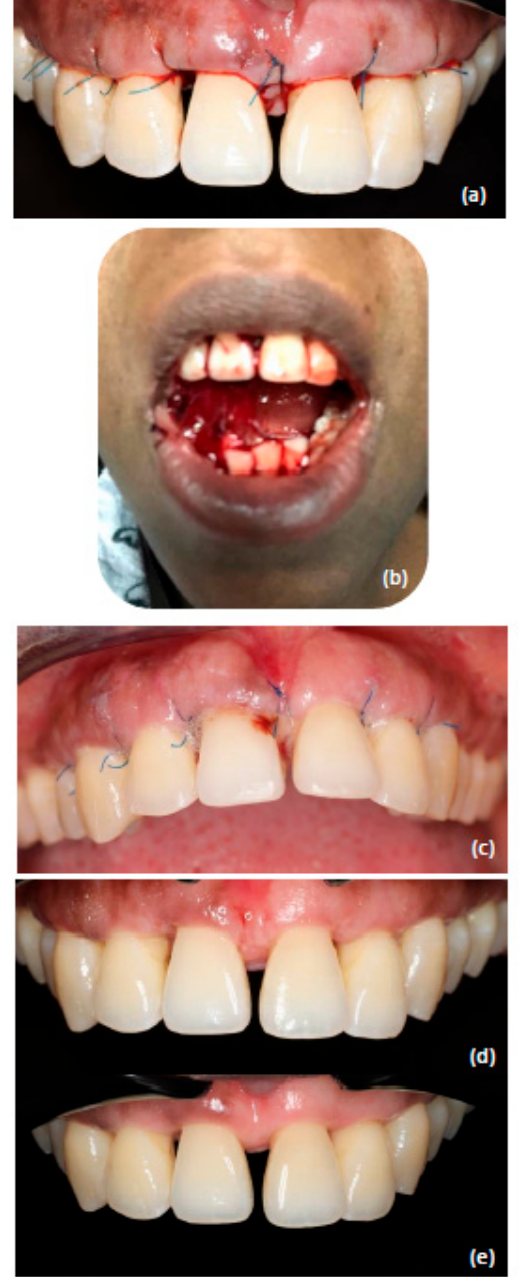
Figure 3. ( a ) Direct post-operative intraoral view. ( b ) Intraoral view as sent by the patient on day 2. ( c ) Intraoral view on day 3. ( d ) Intraoral view 3 weeks post-operative immediately after suture removal. ( e ) Intraoral view 6 months post-operative at the re-evaluation of the surgical phase.